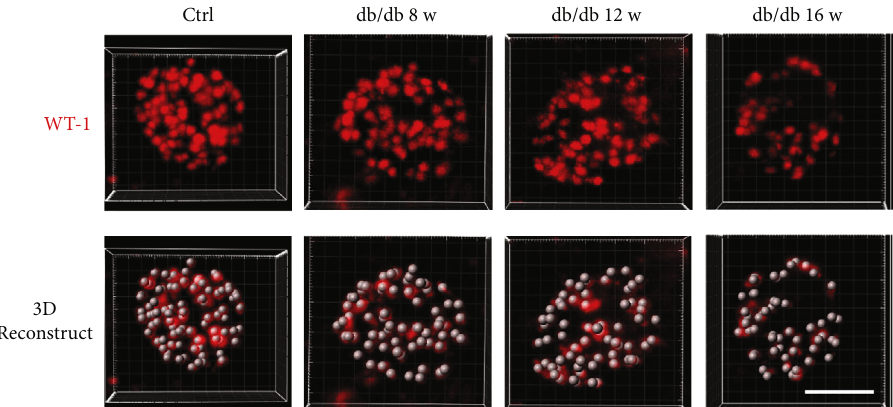
Figure 4: Three-dimensional visualization of podocytes in control and DKD glomeruli. Representative images of podocytes from the control group and db/db mice labeled with antibody to WT-1 (red) by the CUBIC method. Podocytes are visible as higher density of WT-1-stained nuclei is observed within the control group than db/db mice. Shown are representative images from three mice of every group with similar results (scale bar: 50 μ